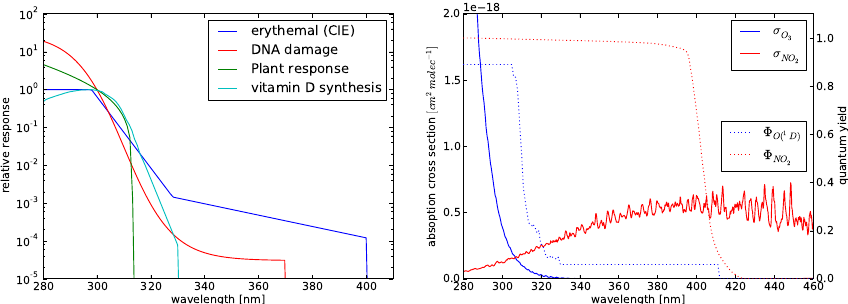
Figure 3. Left: biological weighting functions used in the product. Right: absorption cross sections of ozone and nitrogen dioxide (solid lines, left y axis) together with the quantum yields of their photolysis reactions (dotted lines, right y